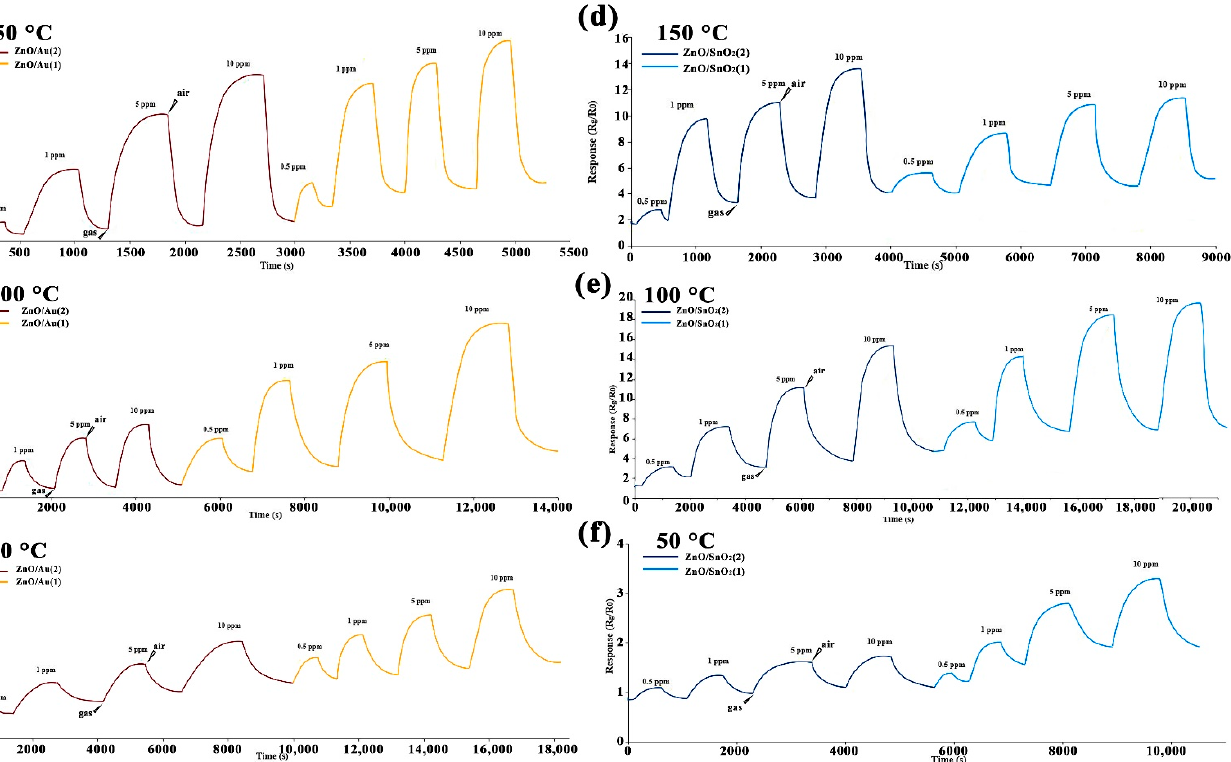
Figure 8. The typical R(t) transients characterizing sensors based on ( a – c ) ZnO/Au(1) and ZnO/Au(2) and ( d – f ) ZnO/SnO 2 (1) and ZnO/SnO 2 (2) when exposed to NO 2 at concentrations of 0.5, 1, 5 and 10 ppm and UV-viz radiation after heating to operating temperatures of 50 °C, 100 °C and 150 °C.